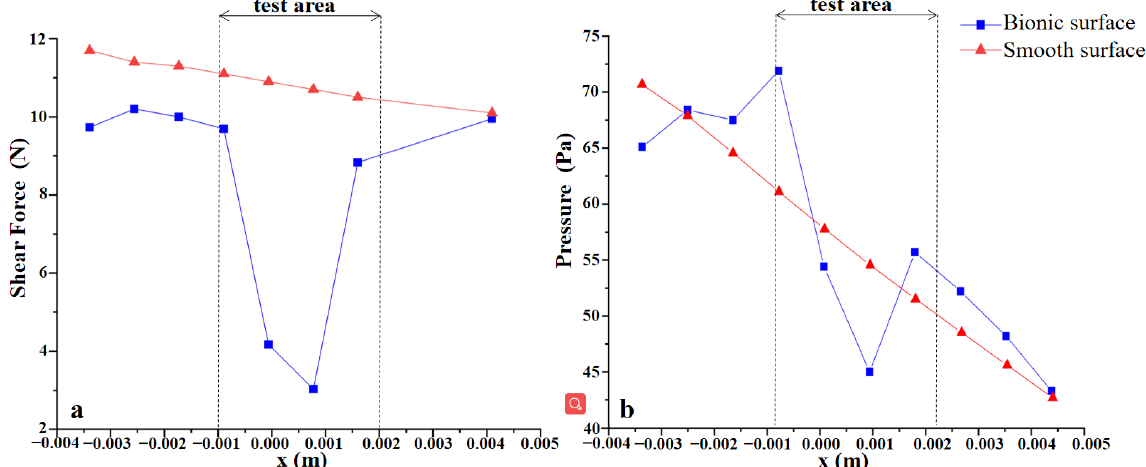
Figure 16. Shear force and pressure diagram of the center line of the test area. ( a ) Shear force line diagram; ( b ) Pressure line diagram.